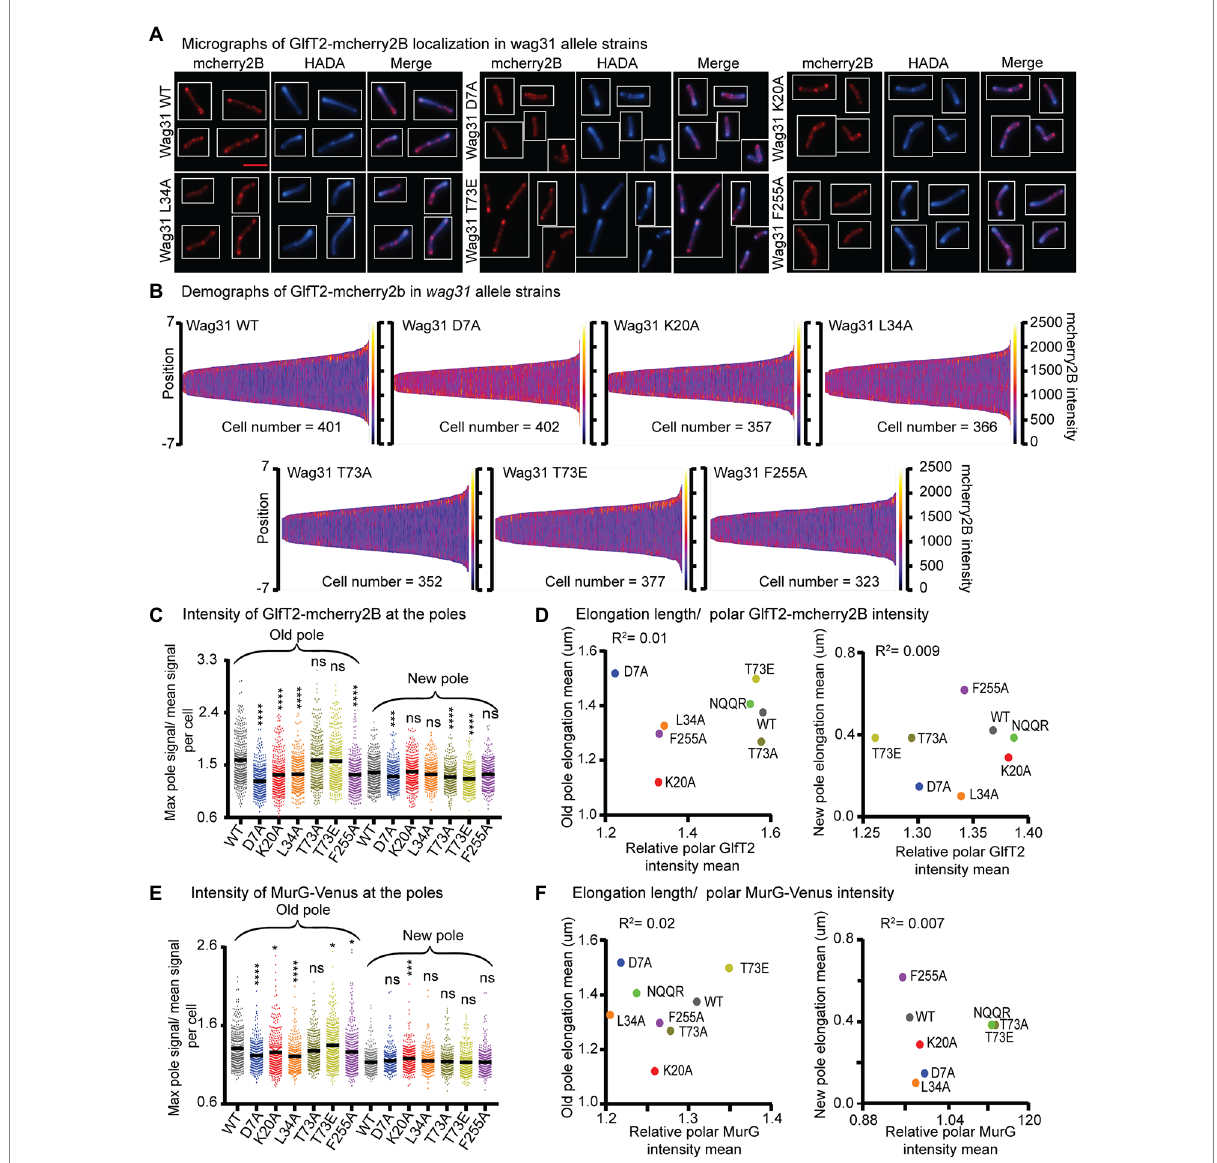
FIGURE 5 Localization of IMD proteins does not determine changes in polar growth. (A) Micrographs of wag31 allele strains expressing GlfT2-mcherry2B and stained with HADA. The scale bar is 5 microns, and it applies to all images. (B) Demographs of GlfT2-mcherry2B intensity across the length of each cell (Y axis of each plot, with intensity indicated by color – scale to the right of each plot), arranged by cell length (along the X axis). At least 100 cells were analyzed for each of three biological replicate cultures. (C) Relative polar intensity of GlfT2-mcherry2B in the Wag31 WT and Wag31 mutants at the old pole and the new pole. Relative intensity is equal to the maximum signal at a cell pole, divided by the mean signal of that cell. (D) Correlation between relative polar intensity of GlfT2-mcherry2B and elongation length (Figure 1J) at the poles. The eight mutants shown as colored dots. (E) Relative polar intensity of MurG-Venus in the Wag31 WT and Wag31 mutants at the old pole and the new pole. (F) Correlation between relative polar intensity of MurG-Venus and elongation length at the poles. ns, p > 0.05, * p = <0.05, *** p = <0.0005, **** p = <0.0001. p -values were calculated by one-way ANOVA, Dunnett’s multiple comparisons